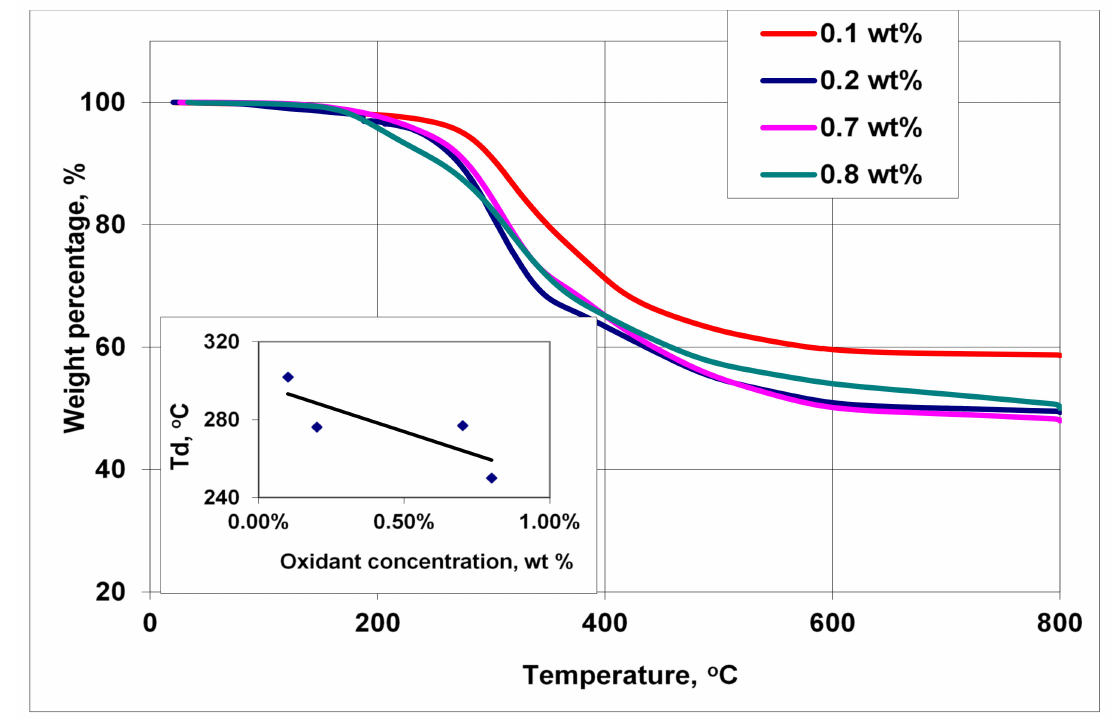
Figure 16. TGA traces for PACN synthesized at varying oxidant concentrations.